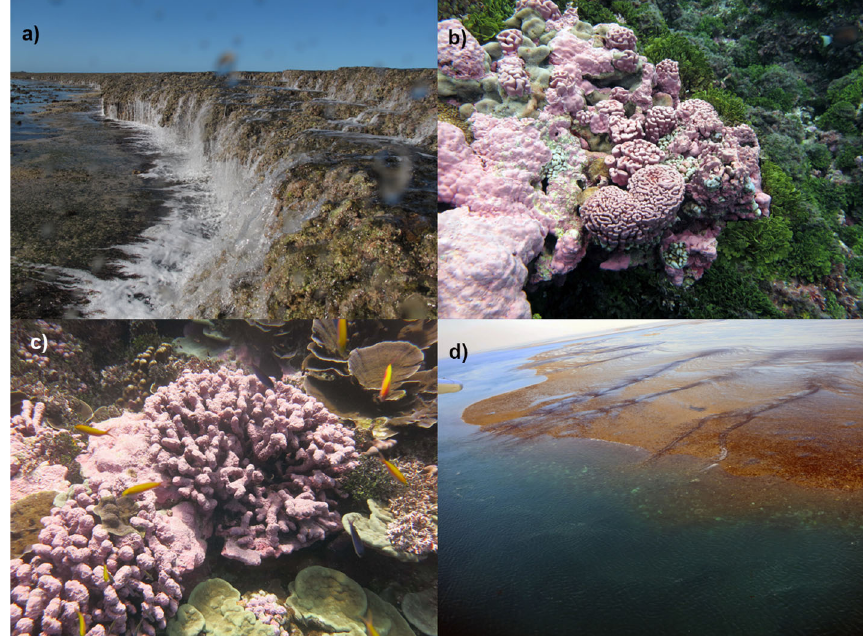
Fig. 2 Examples of crustose coralline algal dominated habitats. a Jalan (or Tallon) Island, the waterfall reef built of coralline algae in northern Western Australia. b Crustose coralline algal community at Starbuck Island, Kiribati. c Settlement of crustose coralline algae over dead coral at Millennium Atoll, Kiribati. d Montgomery Reef, Australia ’ s largest inshore reef, formed entirely by crustose coralline algae covered by brown